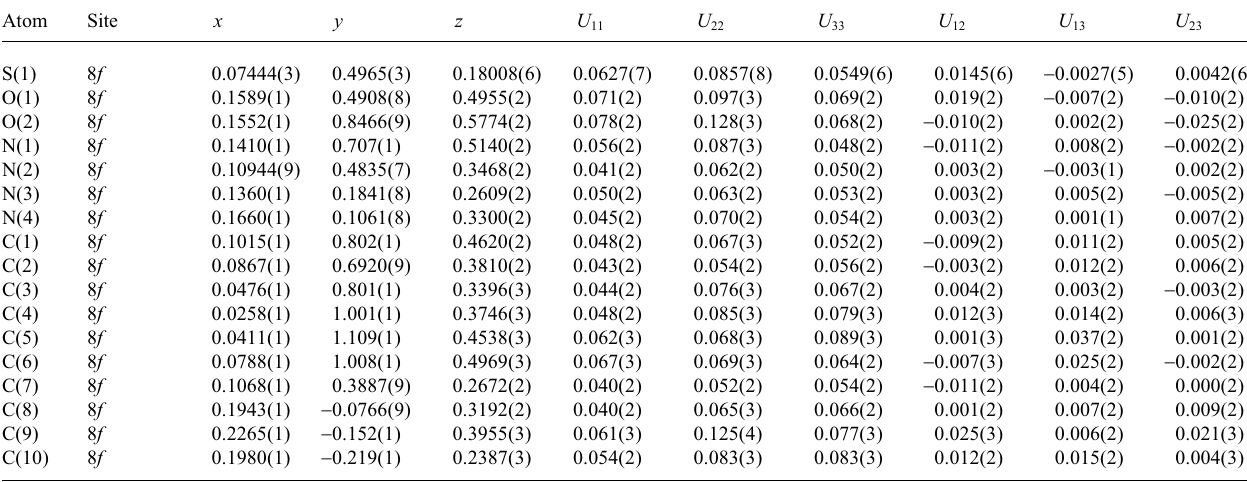
Table 3. Atomic coordinates and displacement parameters (in Å 2 )